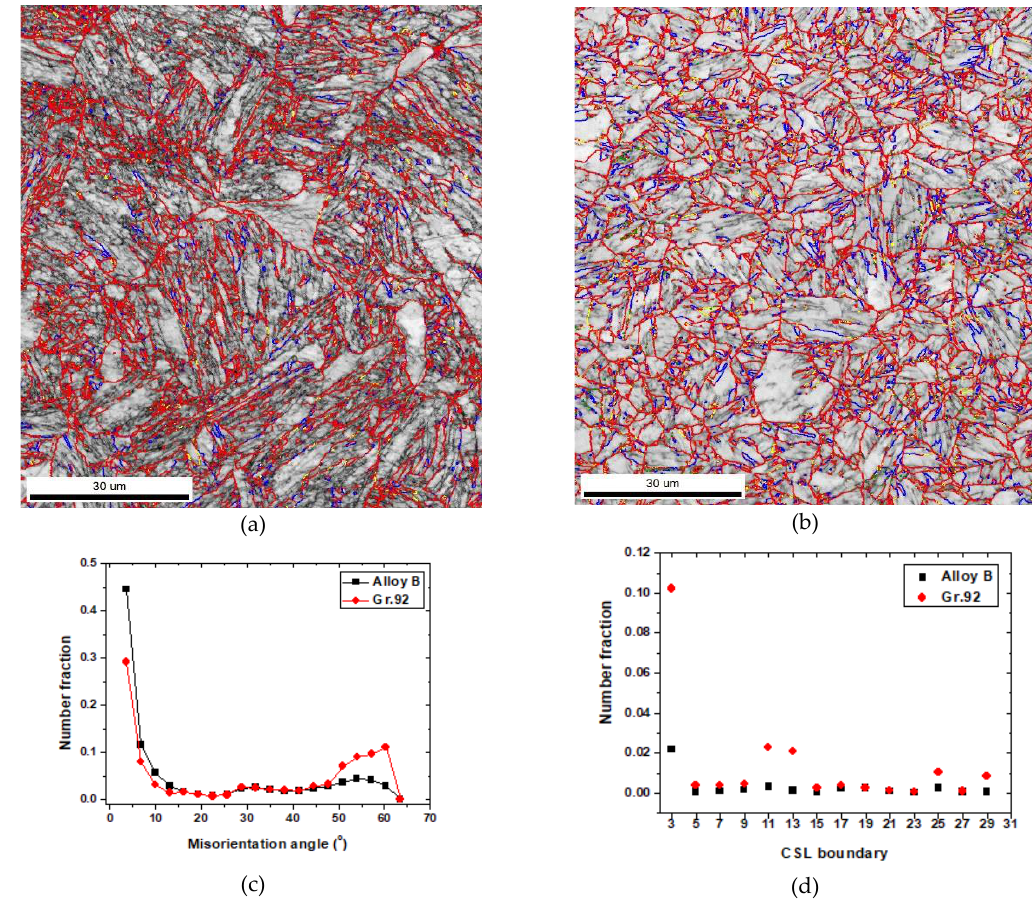
Figure 6. The image quality map and grain boundary character distribution (GBCD) of the alloy B and Gr.92 specimens heat-treated under the 1050 °C, 6 min and 800 °C, 6 min conditions: ( a , b ) the image quality map of alloy B and Gr.92 are denoted by the high angle grain boundary (HAGB) (mis orientation angle > 15, color code: red) and CSL boundary (color key: Σ 3—blue, Σ 11—yellow, Σ 17—violet, Σ 19—brown, Σ 25—orange ( c ) misorientation angle distribution plot, and ( d ) coincidence site lattice (CSL) boundary distribution plot.